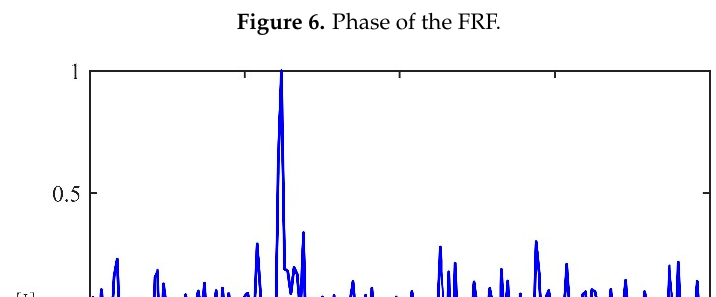
Figure 6. Phase of the FRF.